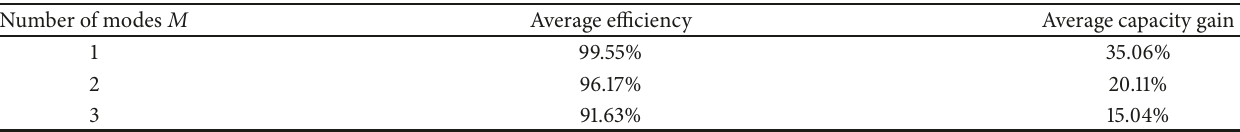
Table 2: Average efficiency and capacity gain with different modes along the